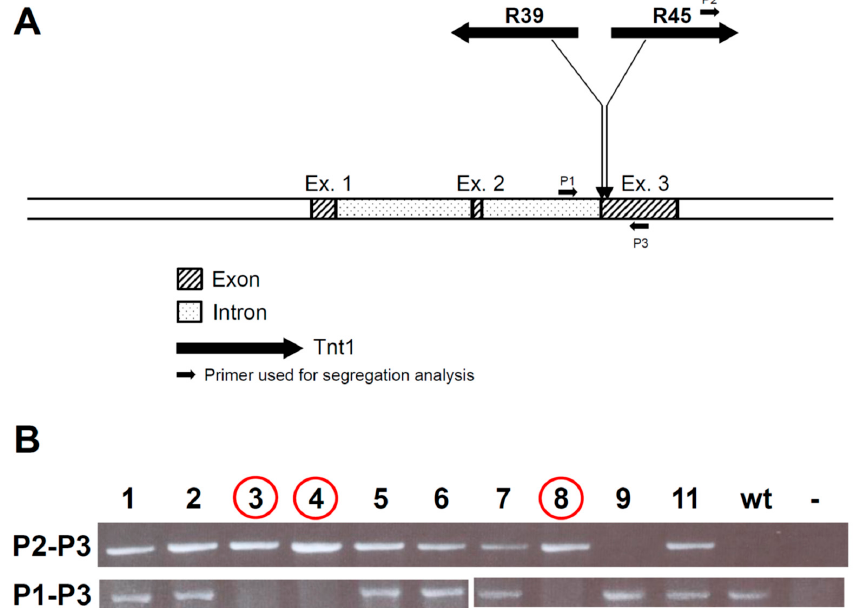
Figure 2. Intron-exon structure of MtrunR108HiC_012760 corresponding to MtrGSTF7 and position of Tnt1 insertions in exon 3 in R39 and R45 mutant lines ( A ). Segregation analysis on 10 plants in the R45 T 1 progeny. P1–P3 primed amplification fails in presence of the 5kbps Tnt1 insertion. Plants 3, 4 and 8 (circled in red) showed the mutant phenotype ( B ). Anthocyanins were undetectable by spectrophotometric analysis of leaves of both R45 and R39 homozygous individuals. A segregating progeny of an R45 heterozygous sib was cultivated in vitro on anthocyanin inducing medium (6% sucrose). Even under these conditions, we could not detect anthocyanins in leaves of R45 homozygous individuals, whereas individuals heterozygous for the insertions accumulated anthocyanins in leaves, though at levels significantly lower than wild-type sibs (Figure 3). R45 mutant sibs did not show qualitative differences for PAs when glandular trichomes and seed coats were stained with 4-(dimethylamino)-cinnamaldehyde (DMACA) (data not shown).